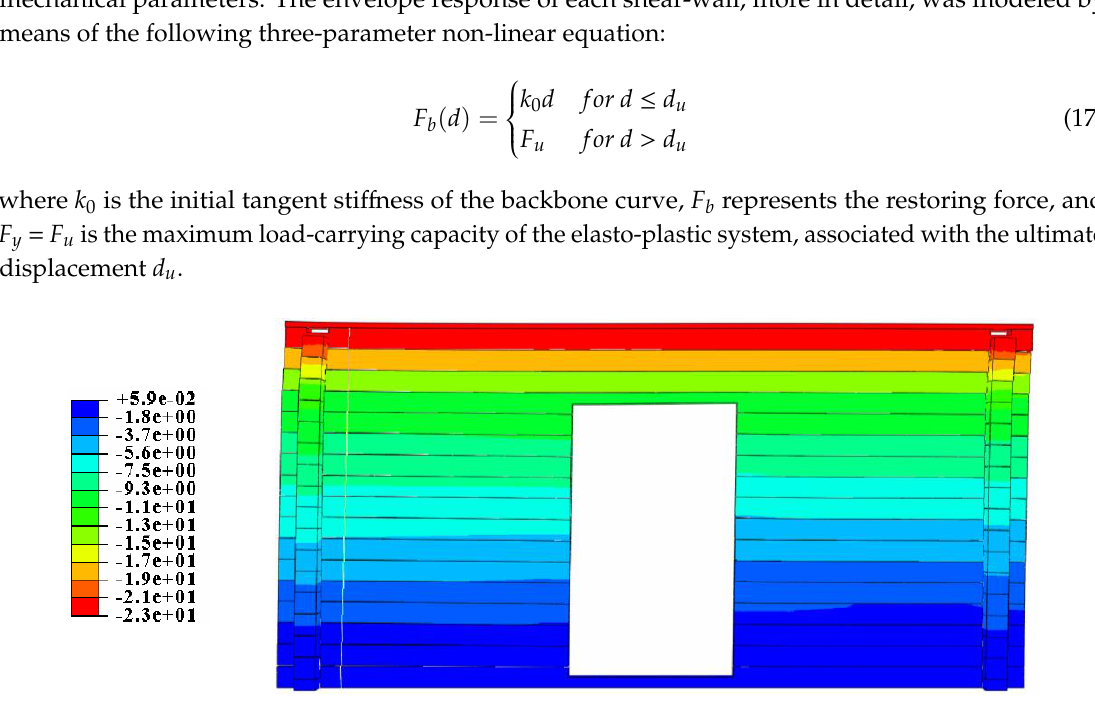
Figure 7. Contour plot of in-plane lateral displacement of the P1-GF portion of log-wall (ABAQUS, legend values in mm).